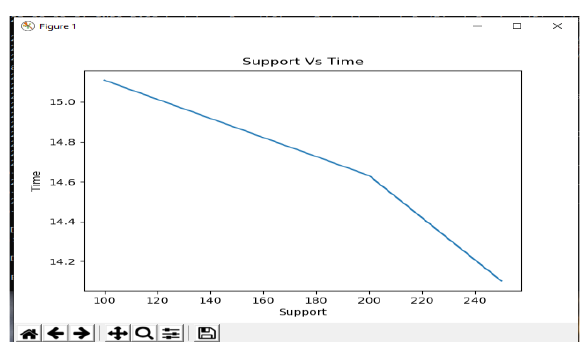
Fig 8:- FP-Growth of Instacart Dataset